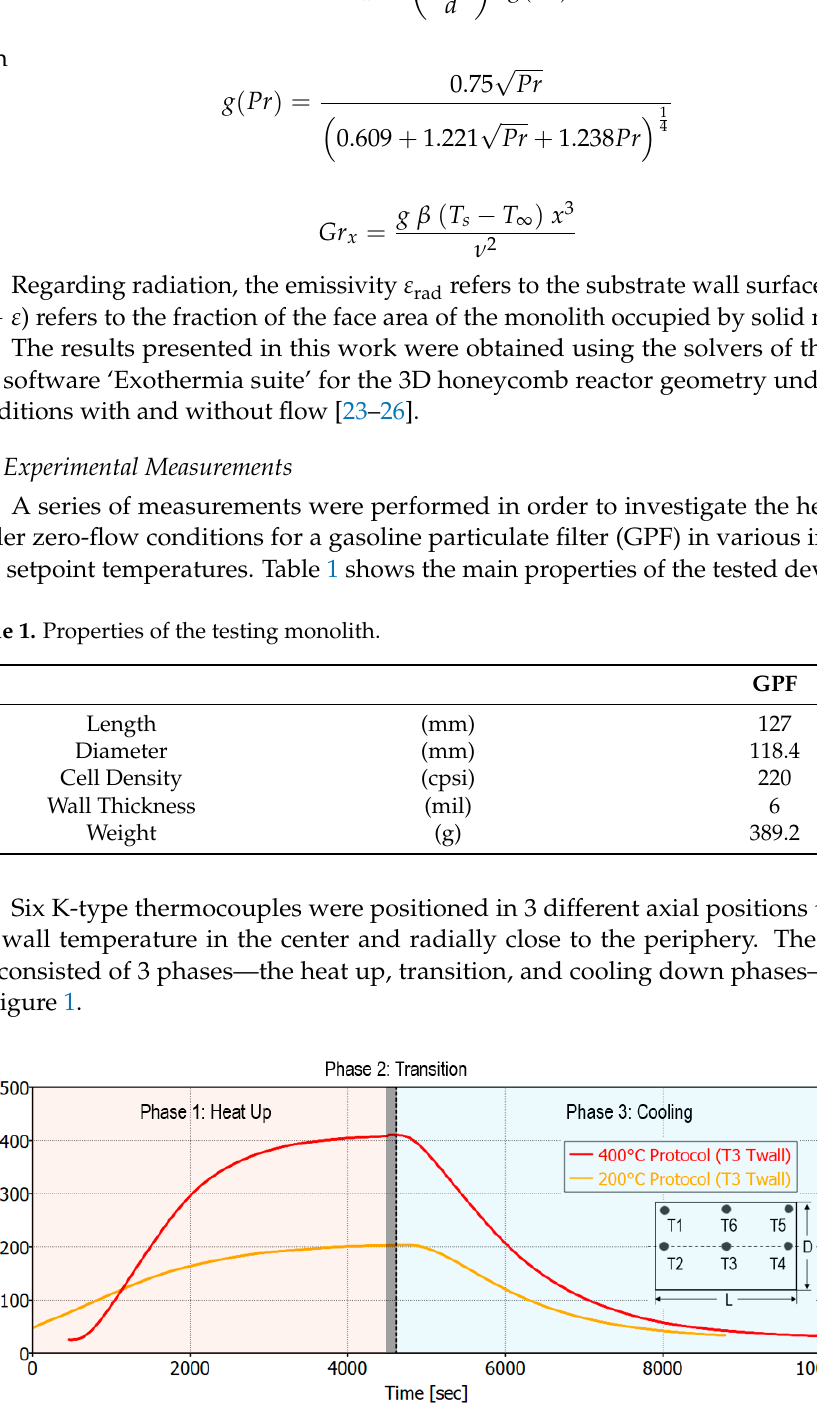
Figure 1. Test protocol to study heat losses under zero-flow conditions.